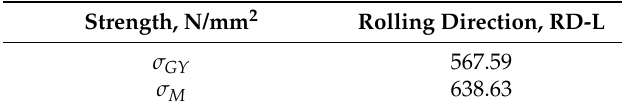
Table 3. Results of strength under dynamic conditions at 21.5 ◦ C.